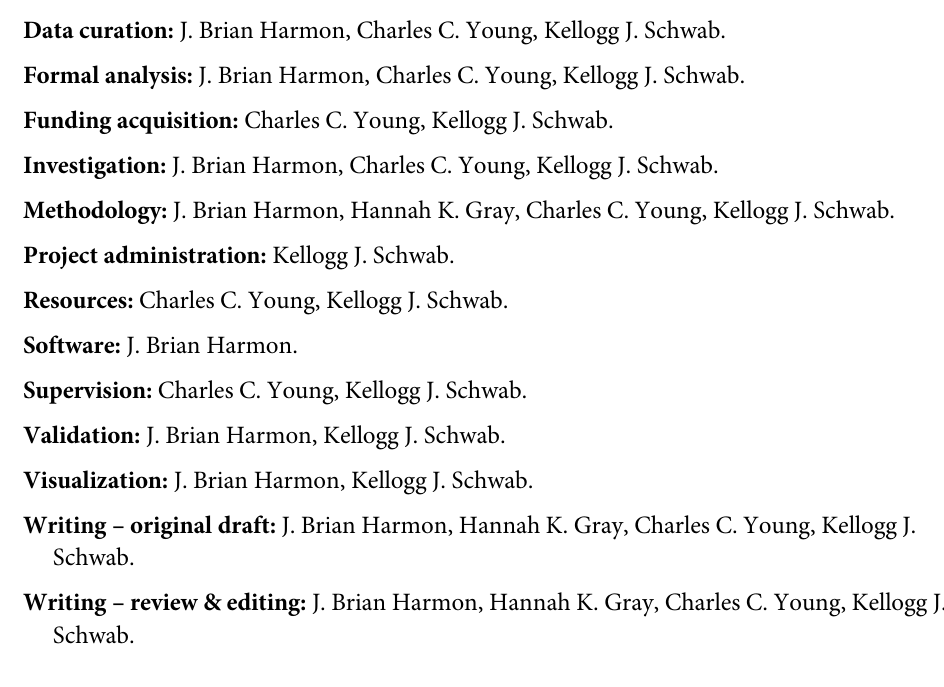
S15 Fig. Bright field images of E . aerogens incubation in-droplet with 0.5x shredded lettuce wash water, and 10 μ g/ml FITC-Ab in 1x RV broth at